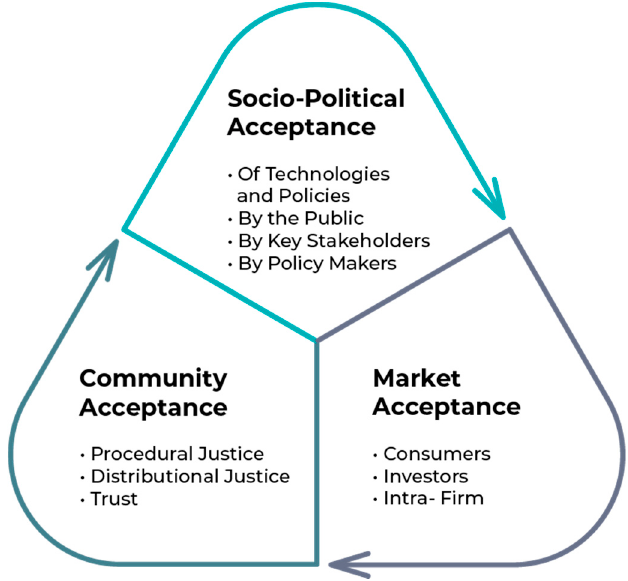
Figure 3. The triangle model (modified after Wüstenhagen et al., [65]).